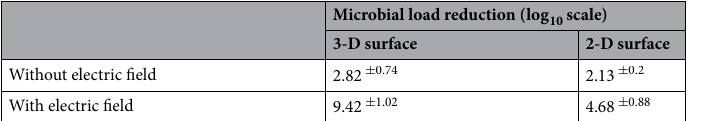
Table 1. Effect of electric field and fabric topography in flow experiments Log 10 -reduction in viable microbial load ( E. coli ) achieved by ZeBox with 3-D and 2-D microbicidal surfaces in 10 min. Applied electric field = 3 kV/cm. Superscripts show standard deviation. Initial load was 10 8 – 10 10